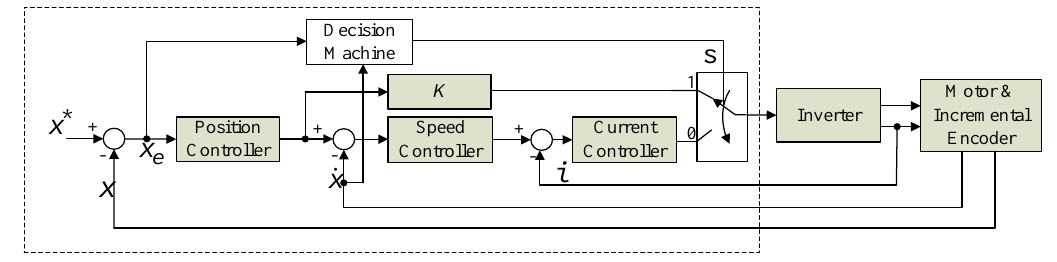
Figure 11. The modified system control structure.